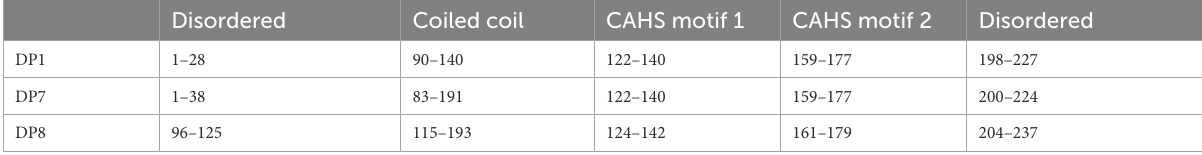
TABLE 2 Positions of family and domains section of CAHS proteins, DB1, 7, and 8, in this study. Disordered